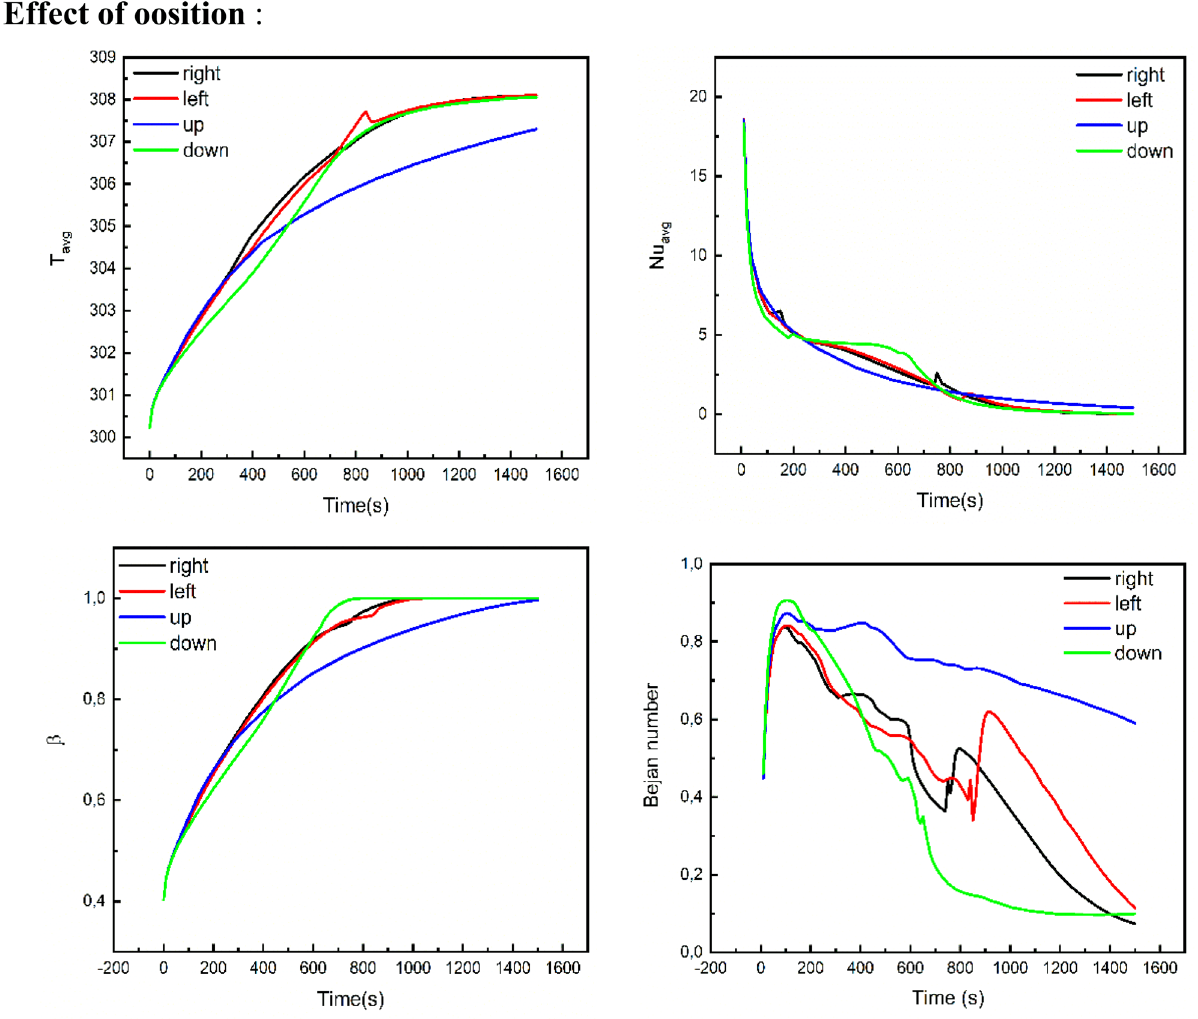
Figure 8. The finned tube position on the Average temperature, Average Nusselt number, Average liquid fraction (β) and Bejan number over